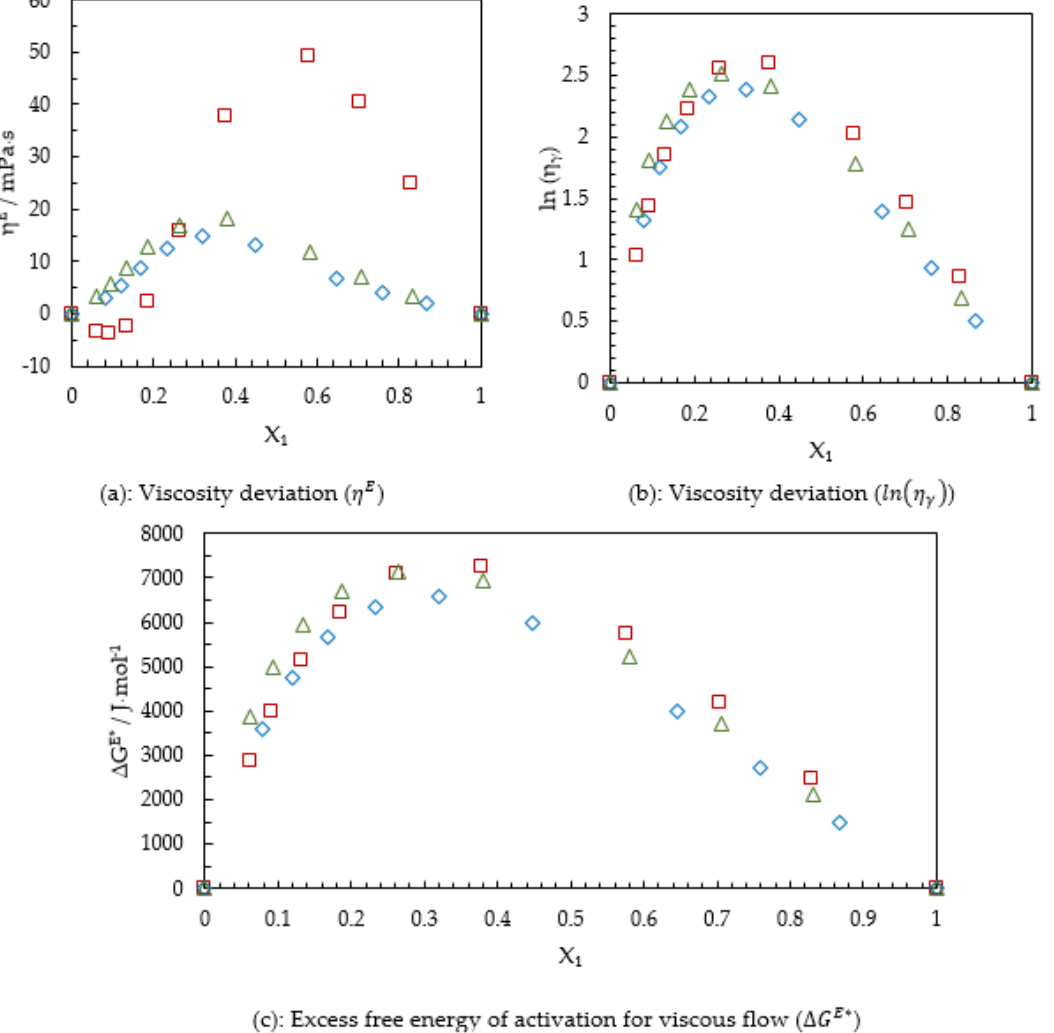
Figure 4. ( a–c ) η E , ln ( η γ ) and ∆ G E * of MDEA (1) + H 2 O (2), ‘ (cid:3) ’; DMEA (1) + H 2 O (2), ‘ ♦ ’ and DEEA (1) Figure 4. ( a–c ) (cid:2015) (cid:3006) , (cid:1864)(cid:1866)(cid:3435)(cid:2015) (cid:3082) (cid:3439) and Δ(cid:1833) (cid:3006)∗ of MDEA (1) + H 2 O (2), ‘ □ ’; DMEA (1) + H 2 O (2), ‘ ◊ ’ and DEEA + H ∆ ’ mixtures at 293.15 2 O (2), ‘ (1) + H 2 O (2), ‘ ∆ ’ mixtures at 293.15 K.